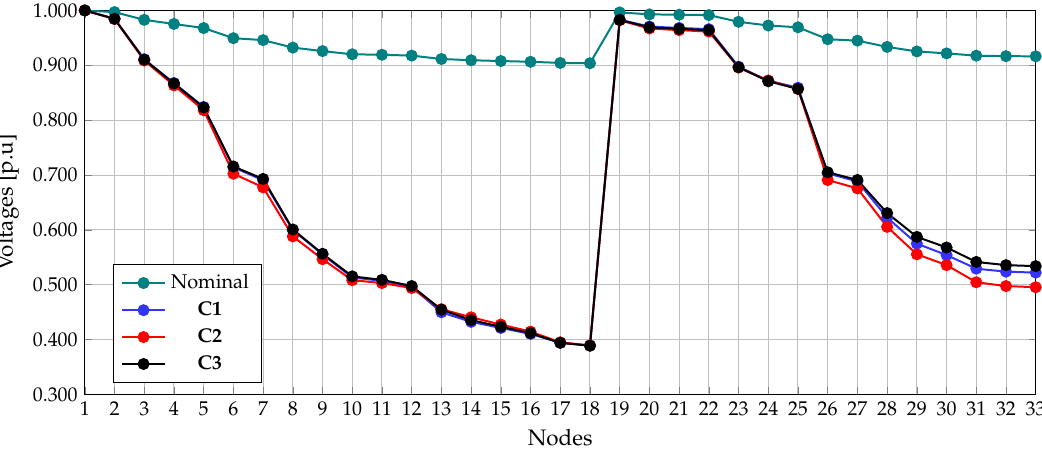
Figure 3. Voltage behavior in the 33-nodes test feeder for the base case and the conditions presented in S1 .